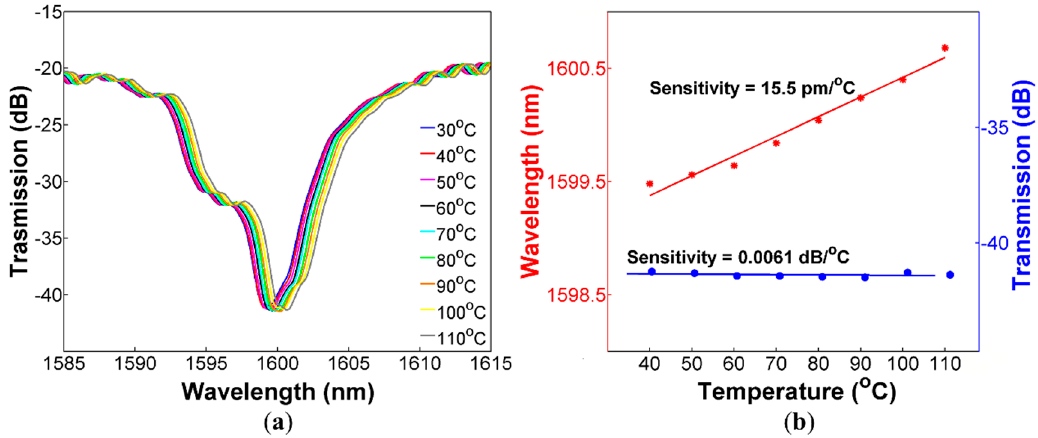
Figure 6. ARROW sensor without PDMS ( a ) Spectral response of the sensor for temperature from 30 to 110 °C; ( b ) Dip wavelength shift and transmitted intensity changes as a function of the applied temperature.